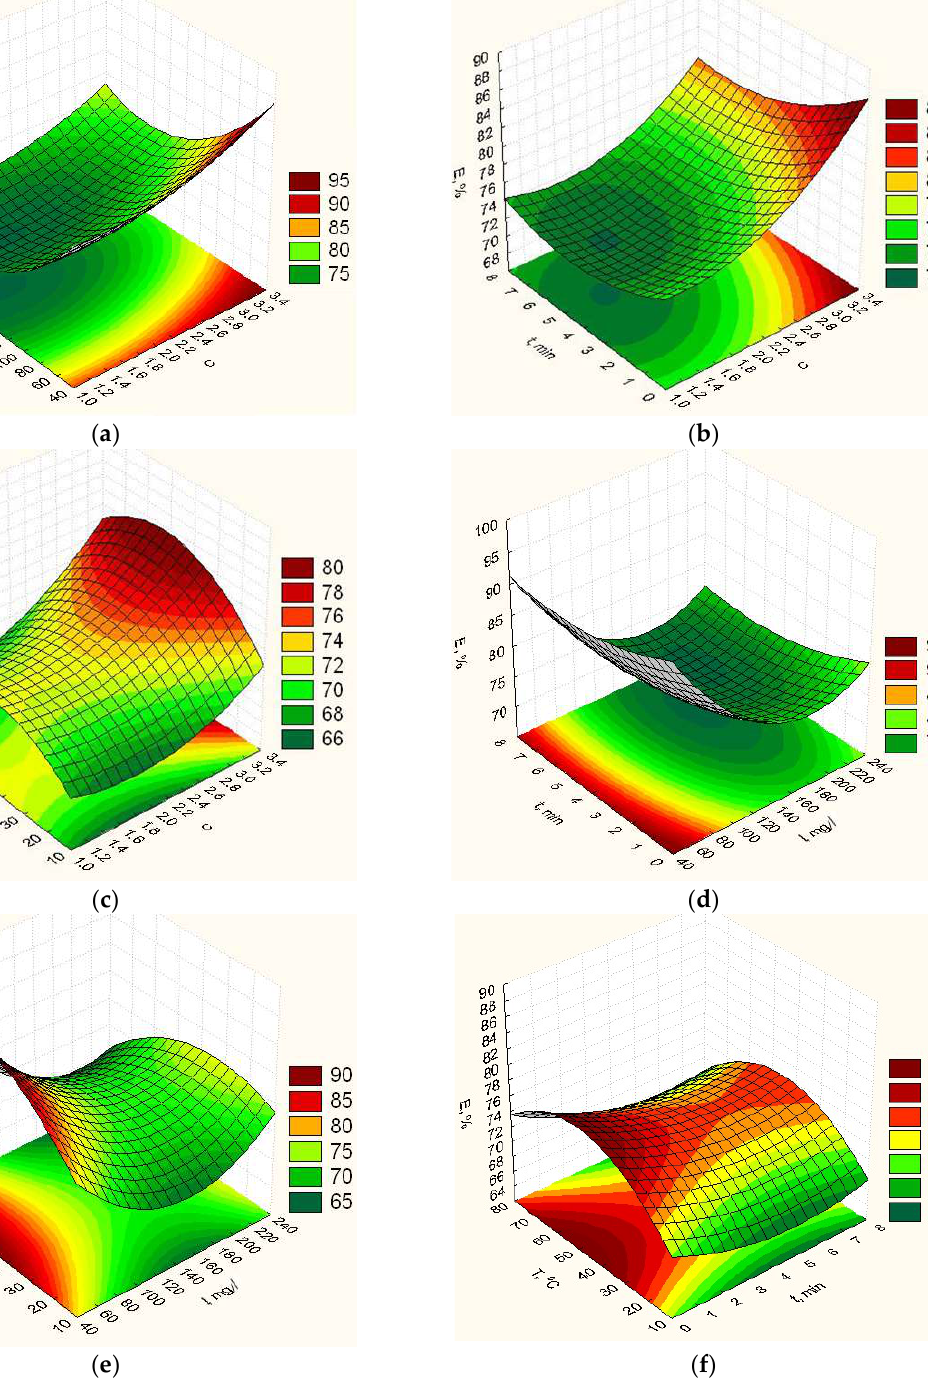
Figure A1. Response surfaces of the dependence of the elasticity of the film on the composition and technological parameters of its manufacture: ( a )— C , I , t = 4 min, T = 46 ◦ C; ( b )— C , I = 140 mg/l, t , T = 46 ◦ C; ( c )— C , I = 140 mg/l, t = 4 min, T ; ( d )— C = 2.2, I , t , T = 46 ◦ C; ( e )— C = 2.2, I , t = 4 min, T ; ( f )— C = 2.2, I = 140 mg/l, t , T